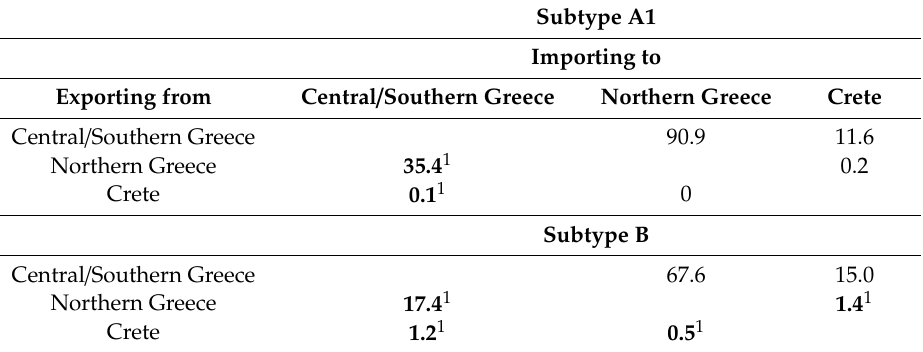
Table 4. Migration matrix representing the mean number of viral migrations events (transmissions) among the di ff erent geographic areas in Greece across all the phylogenetic bootstrap trees ( n = 408), separately for each HIV-1 subtype under